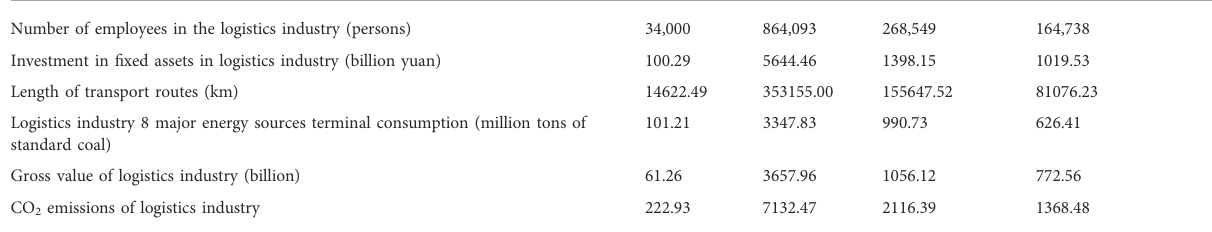
TABLE 3 Descriptive statistics of sample